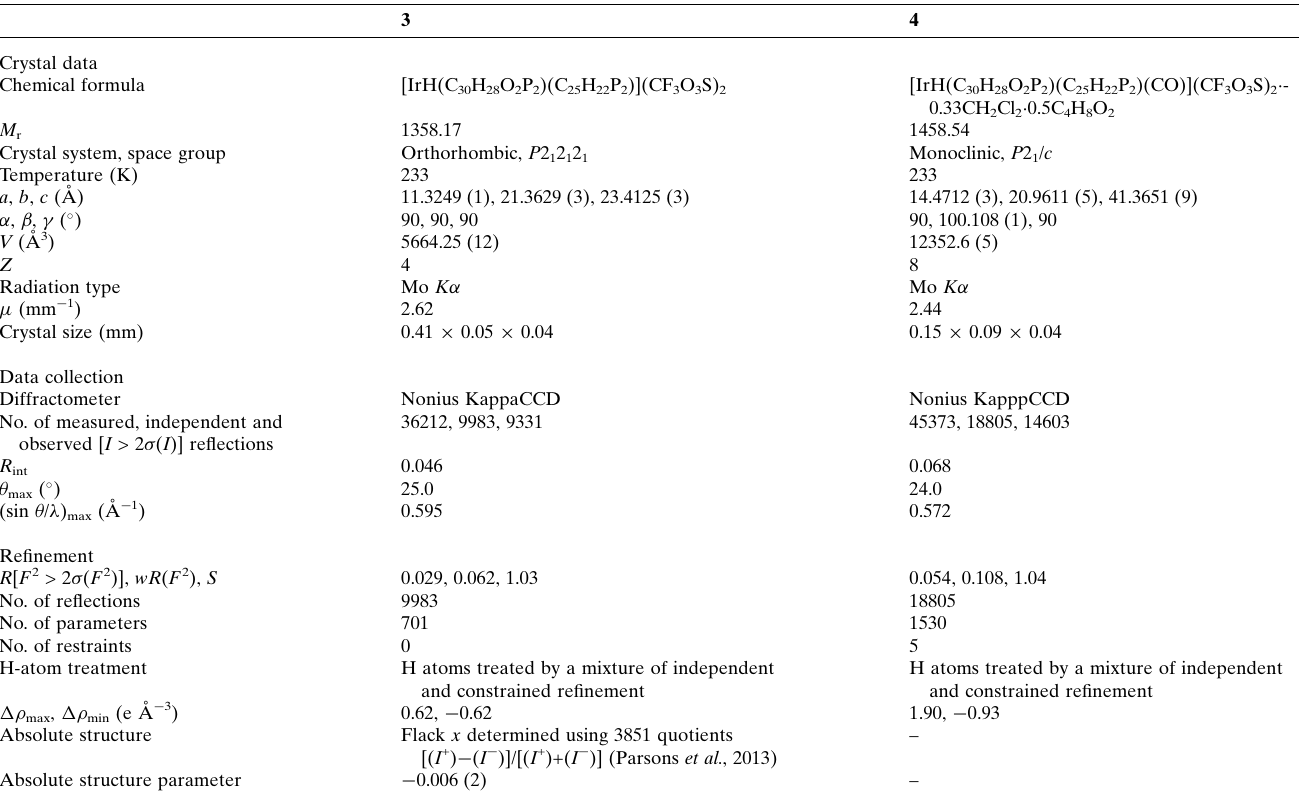
Table 4 Experimental details.